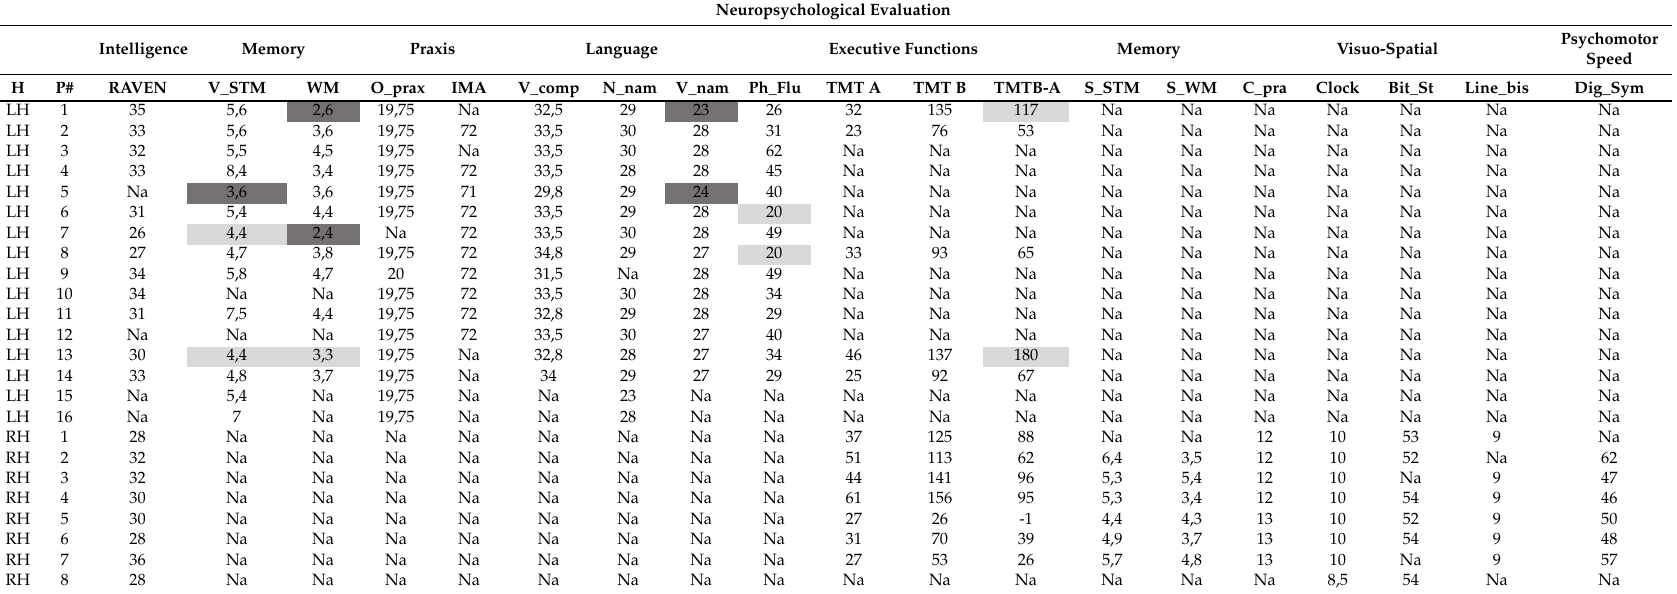
Table 3. Left hemisphere (LH) and right hemisphere (RH) iLGG patients’ neuropsychological profile. Patients performed di ff erent series of tasks according to the hemisphere involved by the lesion. Performance below the normal range is highlighted dark grey. Equivalent scores equal to 1, indicating borderline performance are highlighted in light grey. Patients’ scores were converted into equivalent scores using a 0–4 scale, in which 0 corresponds to a score below the 5% tolerance limits, 4 corresponds to a score equal to or better than the mean, and 1 / 2 / 3 correspond to intermediate scores between 0 and 4, according to the standardization of the